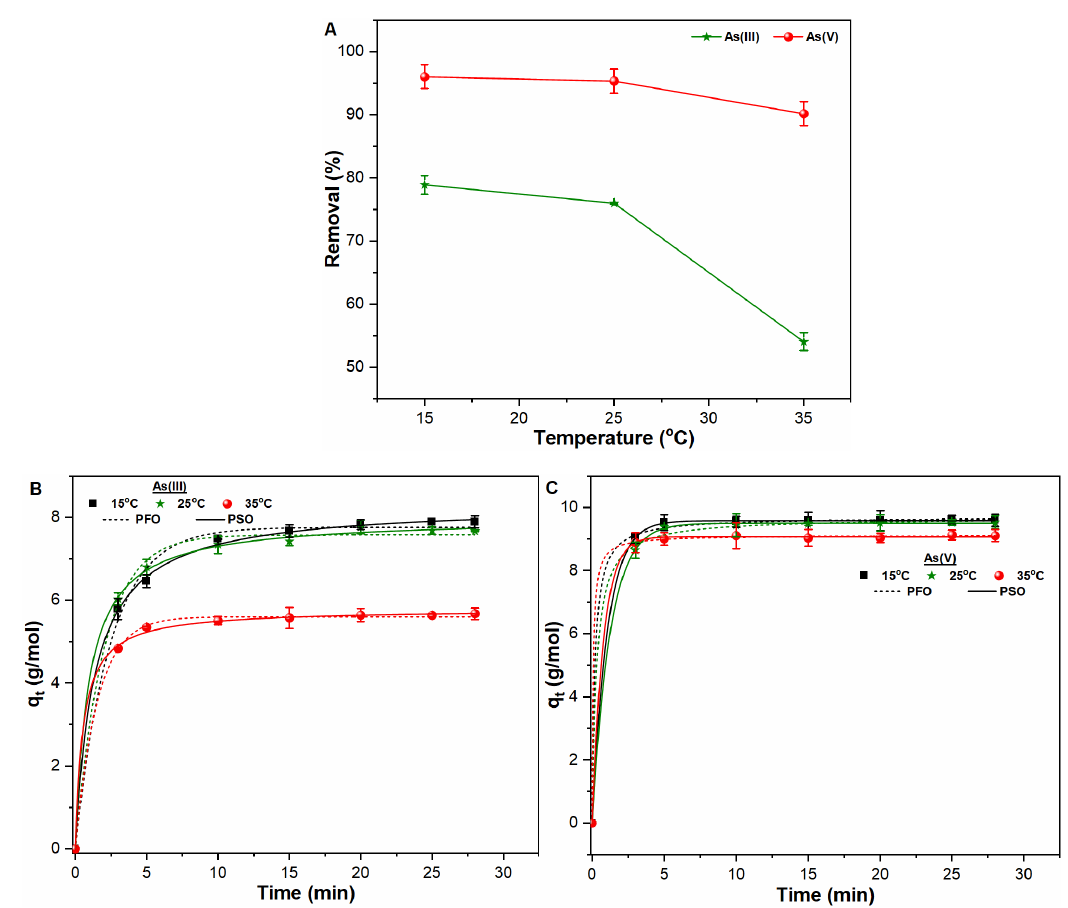
Figure 2. ( A ) Removal of As oxyanions under varying temperature (15–35 ◦ C); and kinetic removal along with fitting parameters of ( B ) Trivalent As; and ( C ) Pentavalent As species from water at pH 7, FC dosage of 0.1 m mol/L, initial As (III, V) concentration (1000 µ g/L), and contact time (0–28